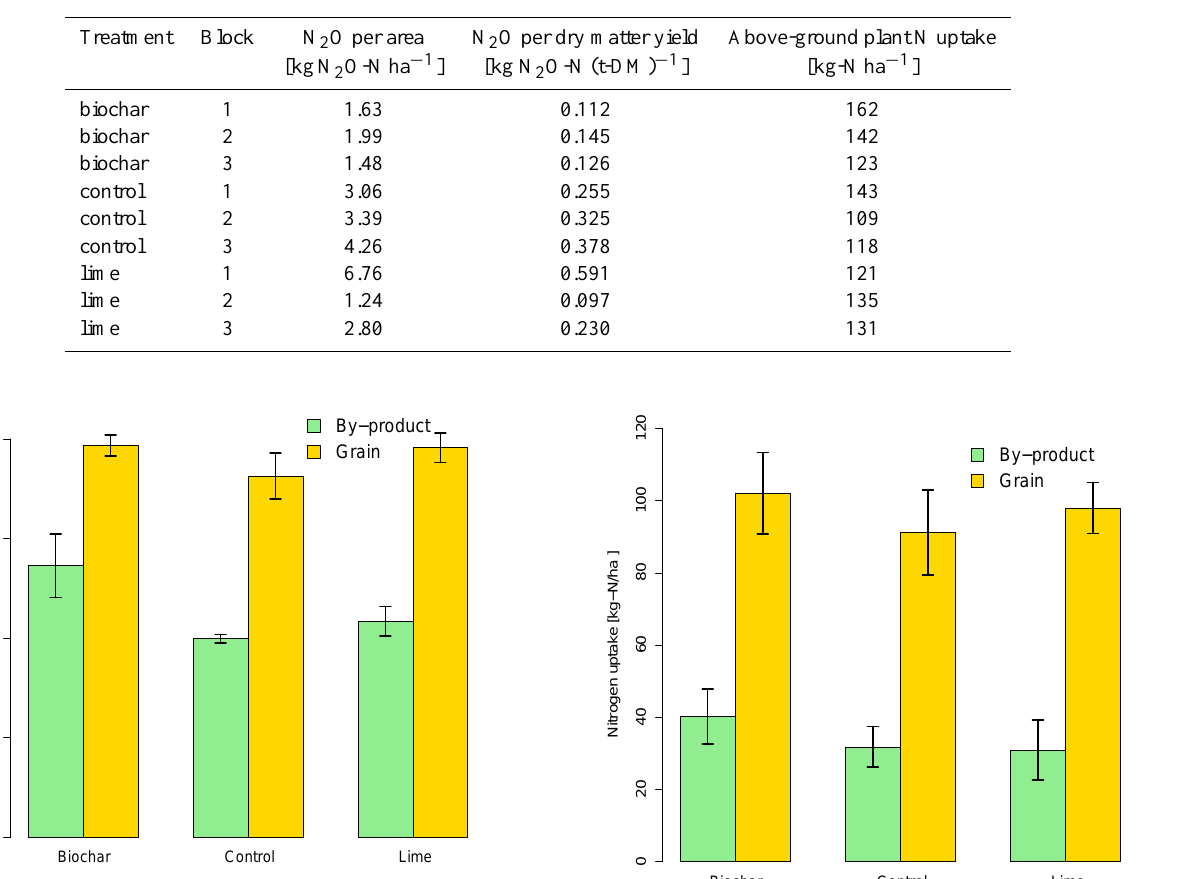
Table 3. Cumulated N 2 O emission per area, above-ground dry matter yield and above-ground plant N uptake for each plot (grains, stems and leaves).